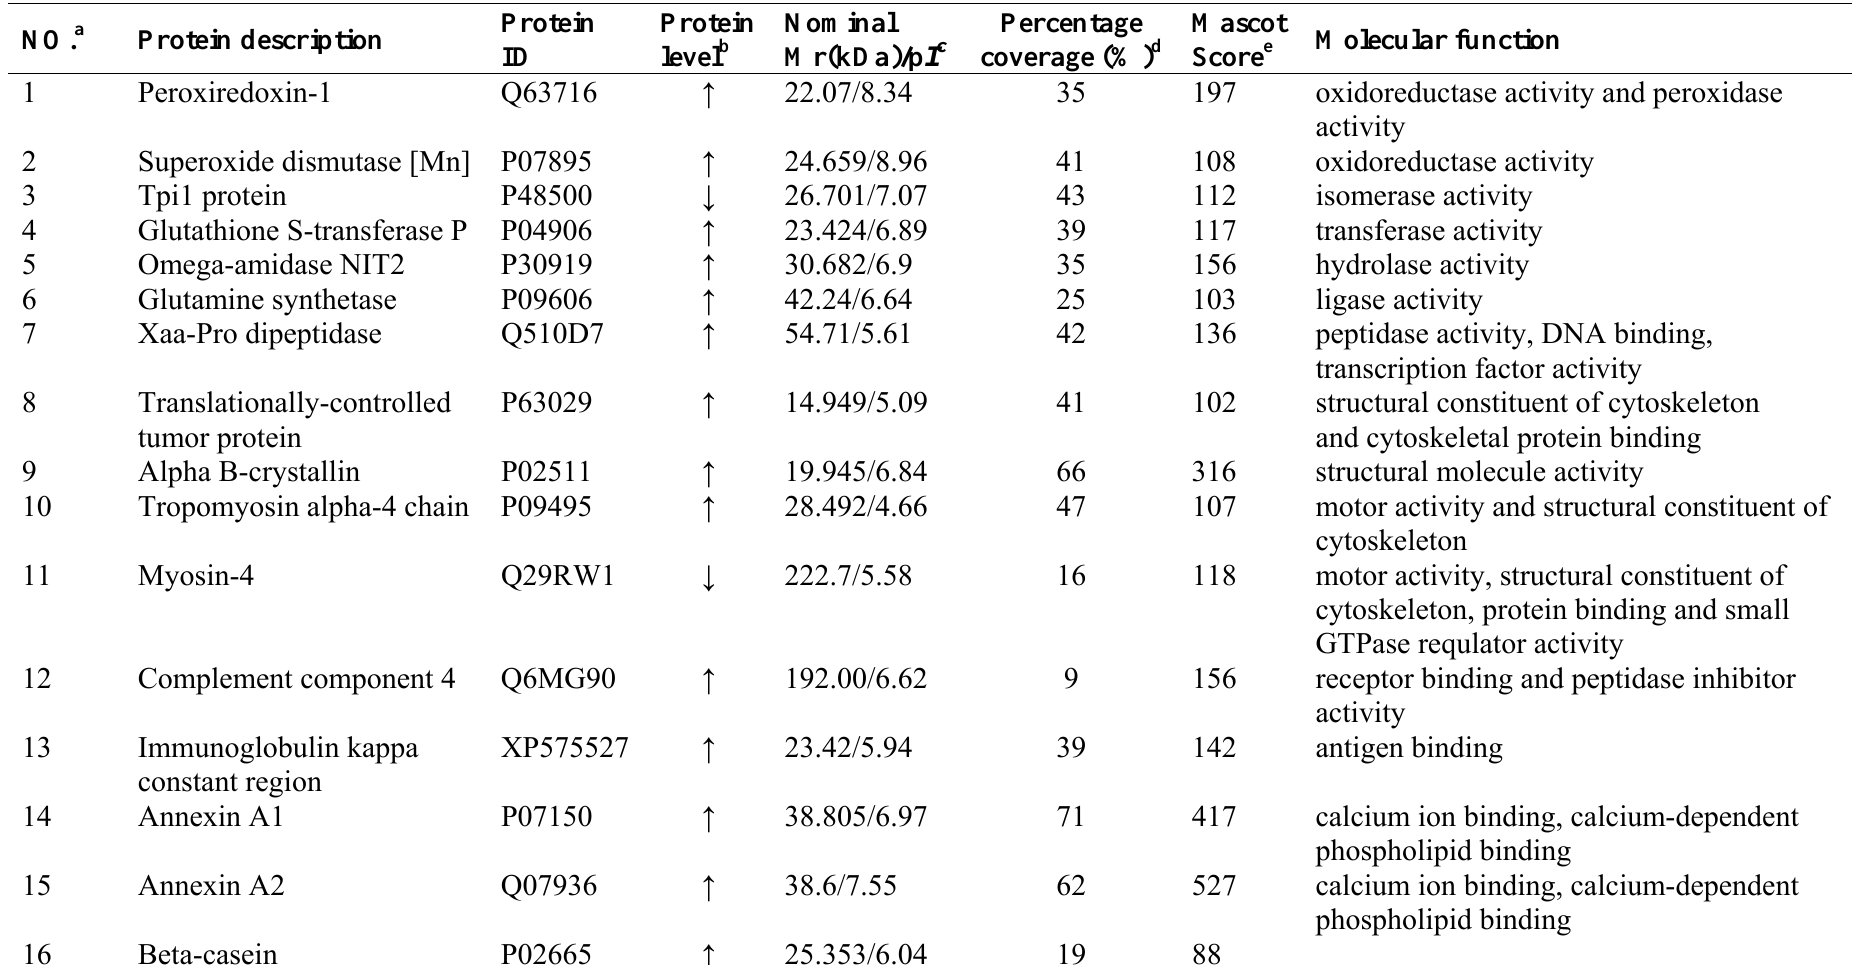
Table 1 ． Identification results of differentially expressed proteins from breast tissues as identified by MALDI-TOF/TOF MS analysis. NO.